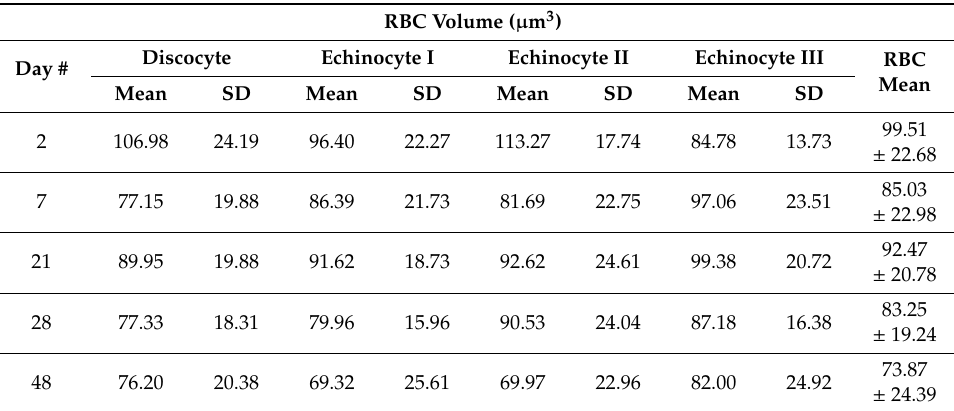
Table A3. Measurements of cell volume of RBC morphologies of three donors during 48 days of in-vitro storage in SAGM additive solution (D. Santangelo, personal communication, 10 October 2018). Mean represents the mean values whereas SD represents the standard deviation.